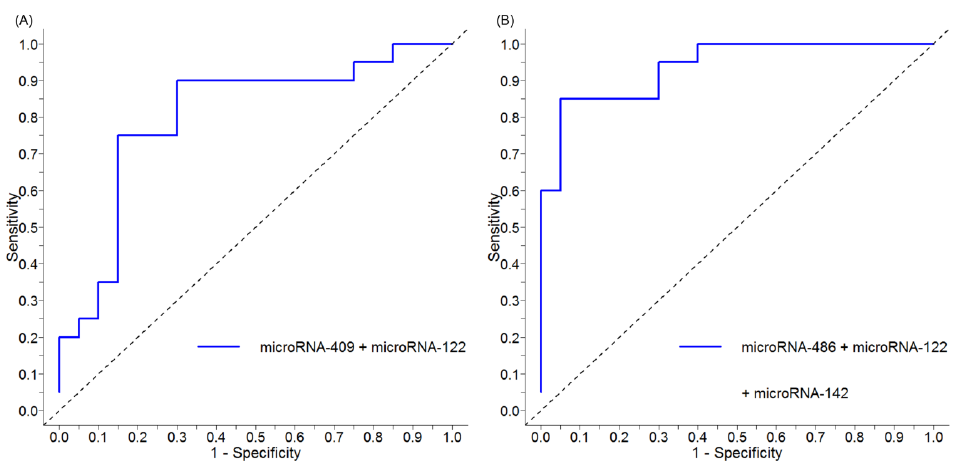
Figure 3. ROC curve of serum miRNA panels to identify cirrhosis or HCC in chronic Hepatitis C ( A ) miRNA panel (miRNA-122-5p and miRNA-409-3p) performance to identify cirrhosis, compared to mild disease, with AUC of 0.80 (95% CI 0.66–0.95, p < 0.001). ( B ) miRNA panel to identify HCC, compared to cirrhosis, using miRNA-122-5p, miRNA-486-5p, and miRNA-142-3p with AUC of 0.94 (95% CI 0.87–1.00, p < 0.001). (Abbreviations: AUC = area under the curve; F0-2 = mild disease; F4 = cirrhosis; HCC = hepatocellular carcinoma; miRNA = microRNA; ROC = receiver operating characteristic; 95% CI = 95% confidence interval).